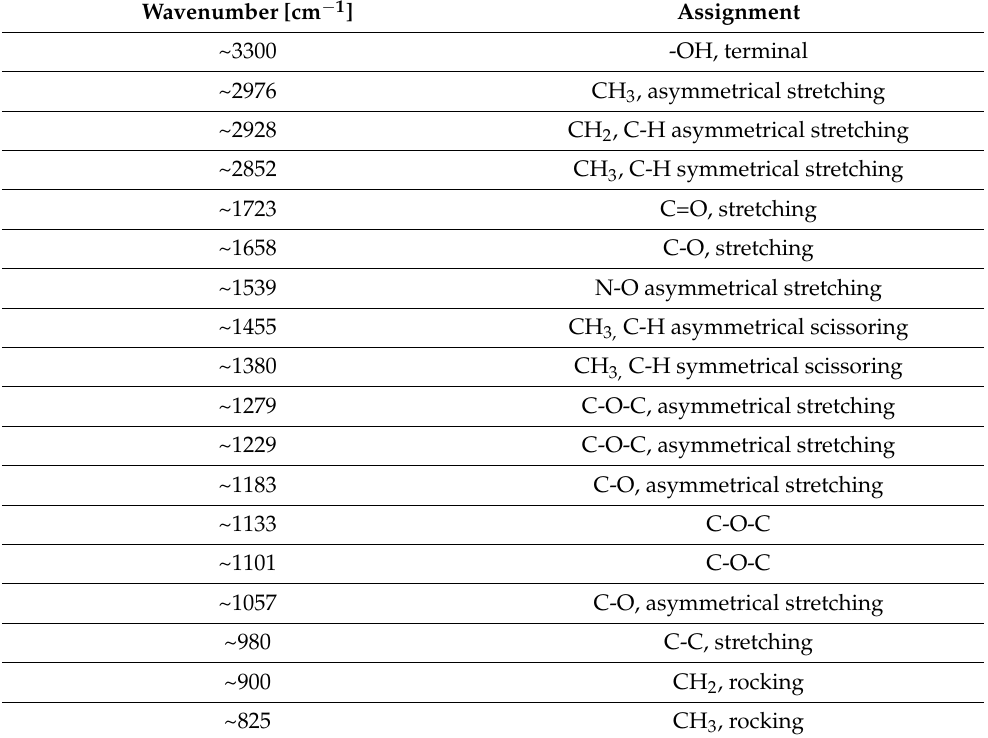
Table 4. Functional group and its quantified frequencies of extracted